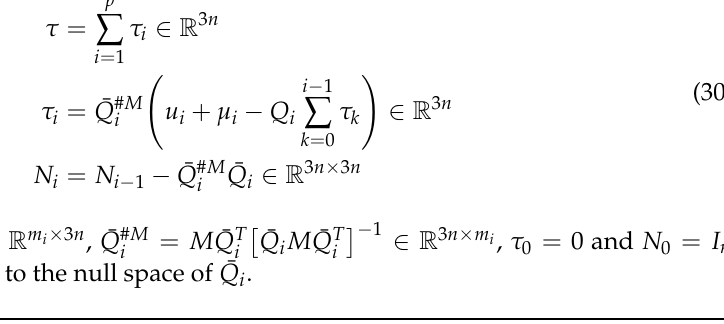
Algorithm 1 Task